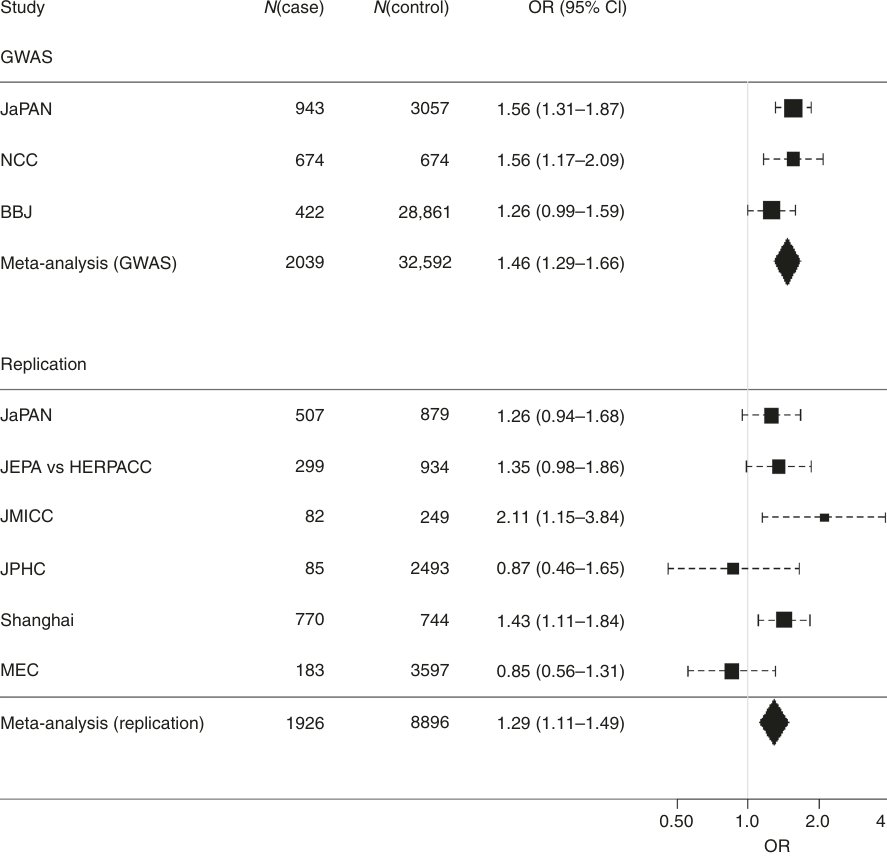
Fig. 3 Forest plot of the association of rs78193826 with pancreatic cancer risk. Study-speci fi c estimates and summary associations are shown. The vertical gray line indicates the null or OR = 1 effect. Horizontal lines through the rectangles indicate the 95% con fi dence interval. Diamonds represent the overall effect size for each meta-analysis. The width of the diamond spans the 95% con fi dence